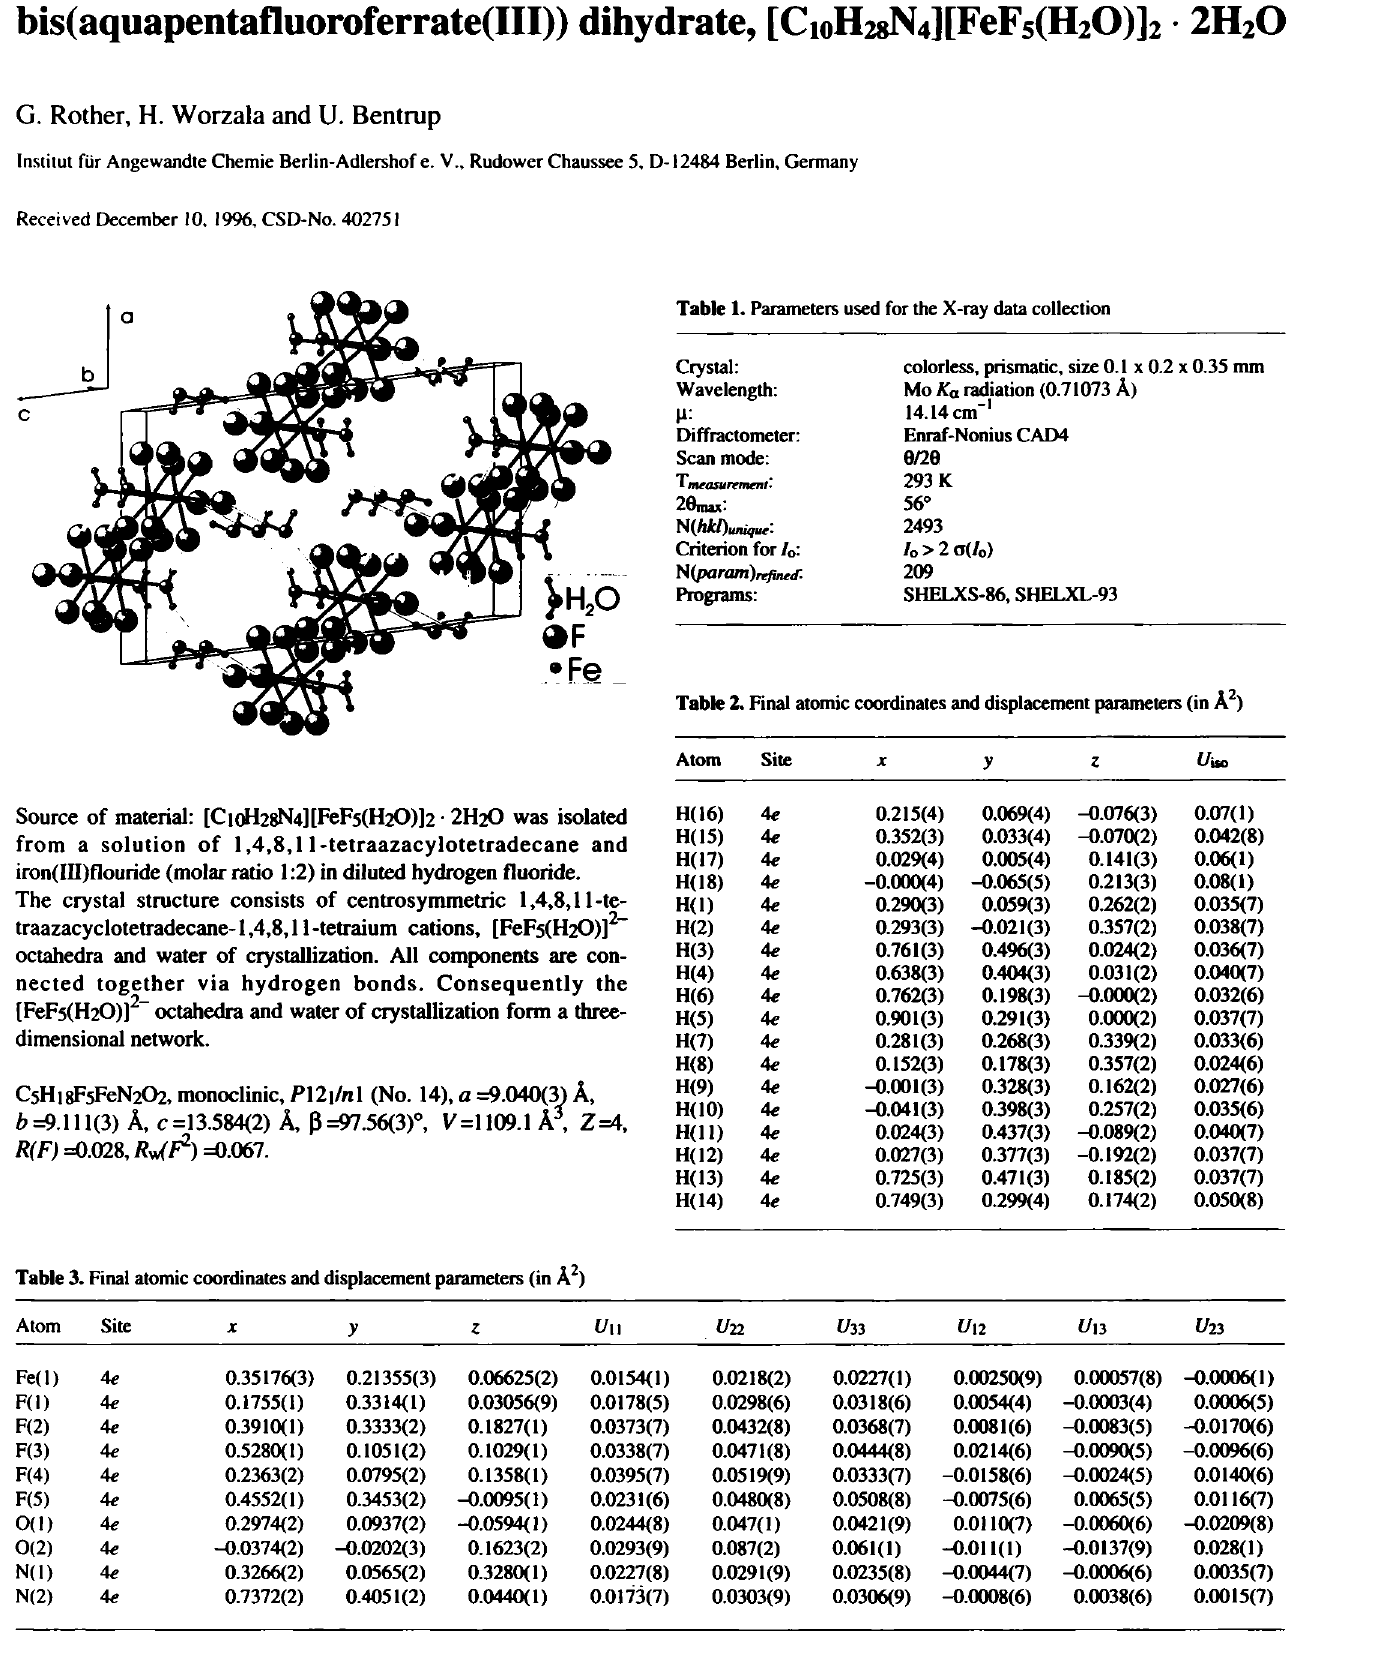
Table 1. Parameters used for the X-ray data collection